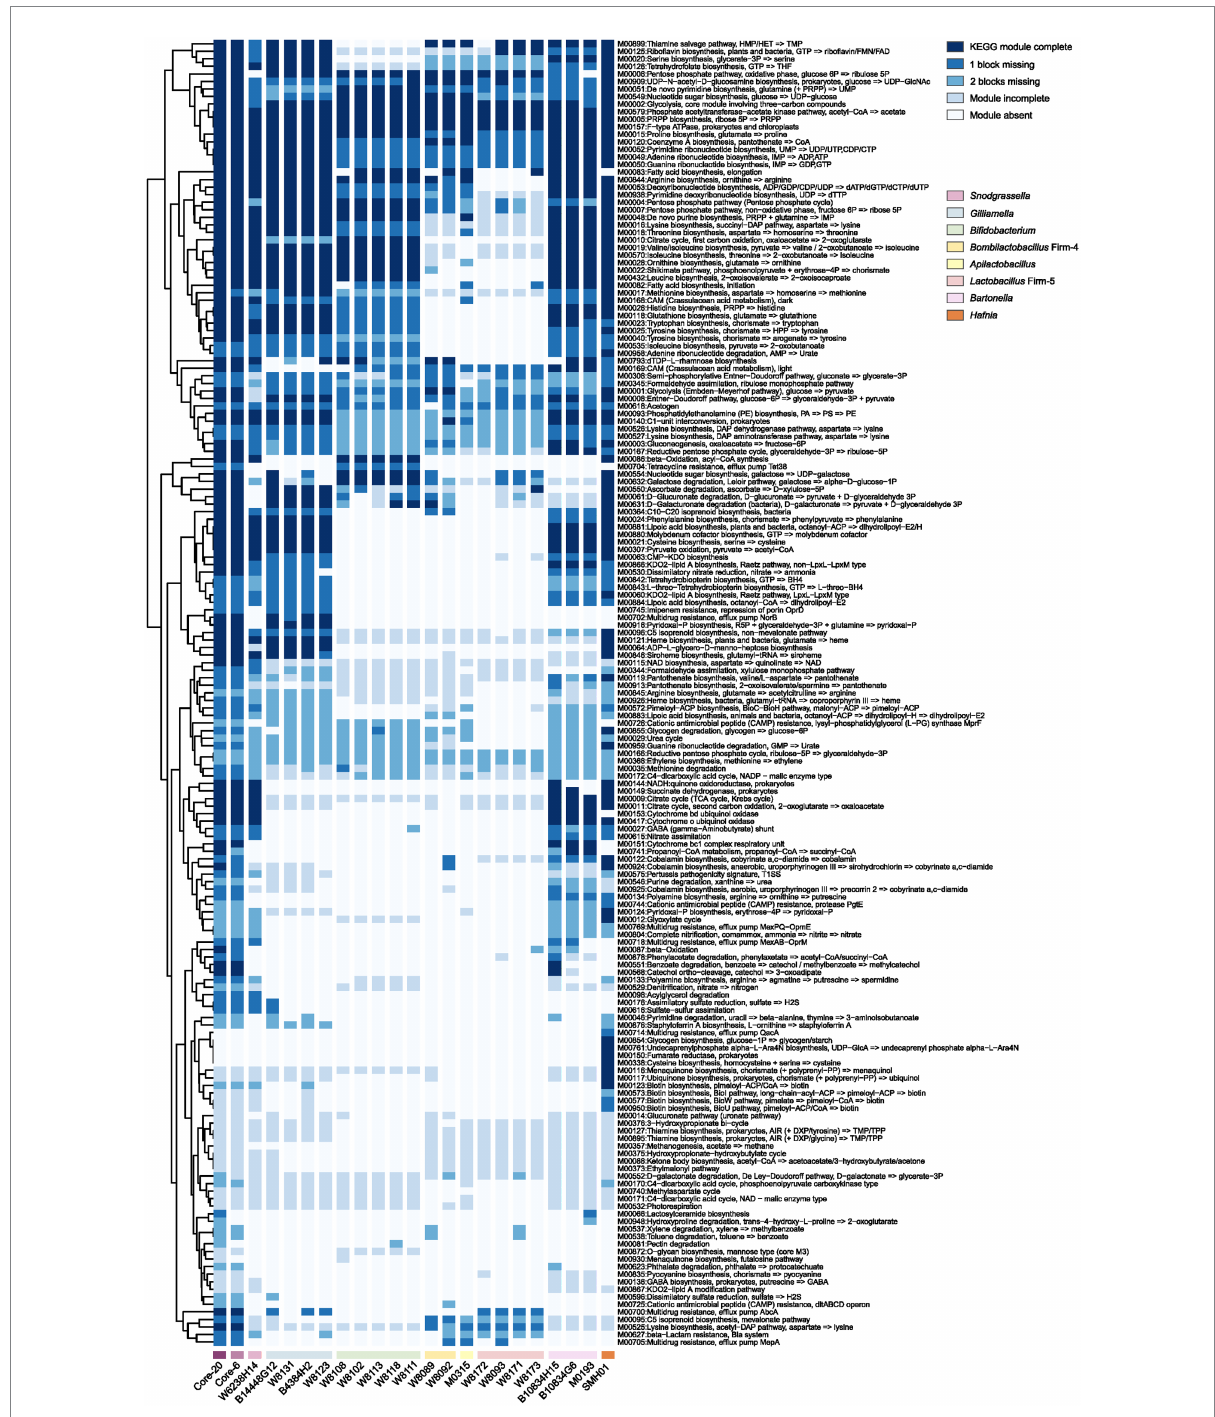
FIGURE 4 The presence and completeness of KEGG modules analysis of individual strains, the Core-6, and the Core-20 community. A hierarchical clustering heat map of KEGG module distribution in the draft genomes and artificial metagenomes. The comparison of the Core-6 and Core-20 shows functional similarity. We also found highly overlapping functions between H. alvei and the Core-20 community, indicating its fitness and potential virulence. The color code indicates the presence and completeness of each KEGG module, expressed as a value between module complete (dark blue) and module absent